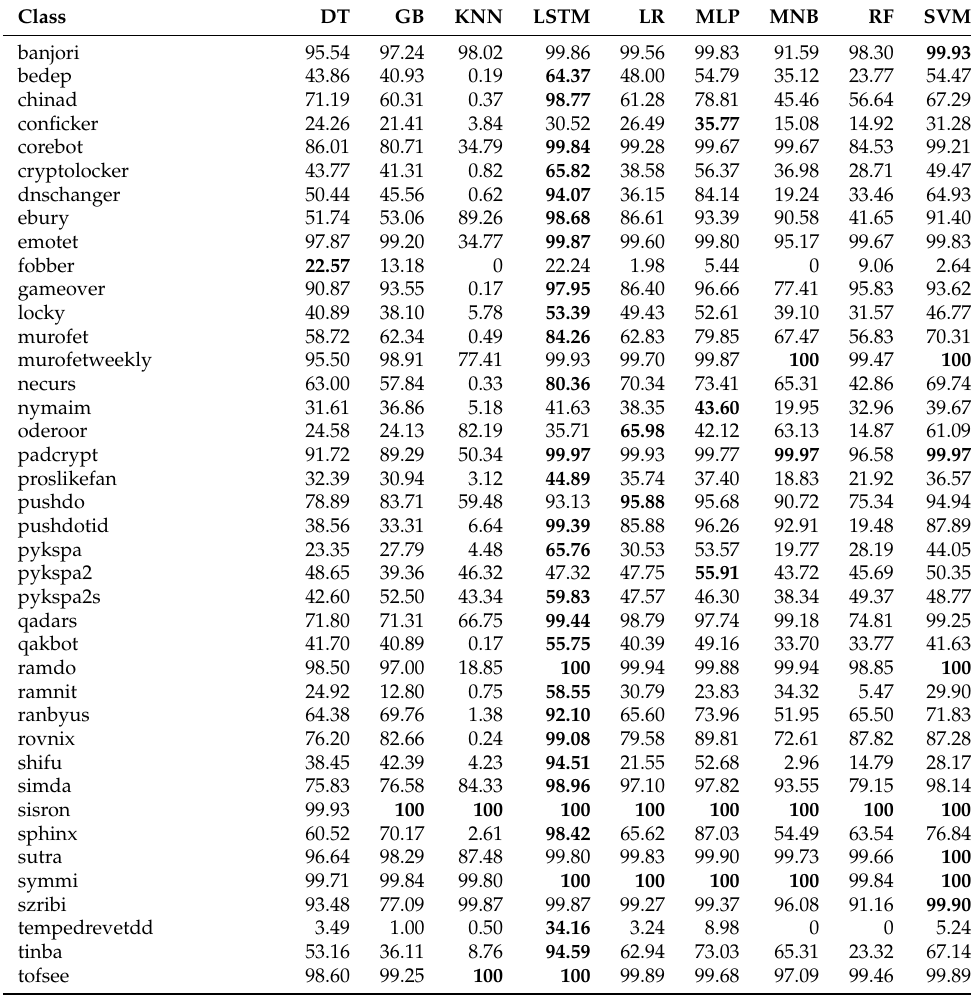
Table A2. Recall (expressed as